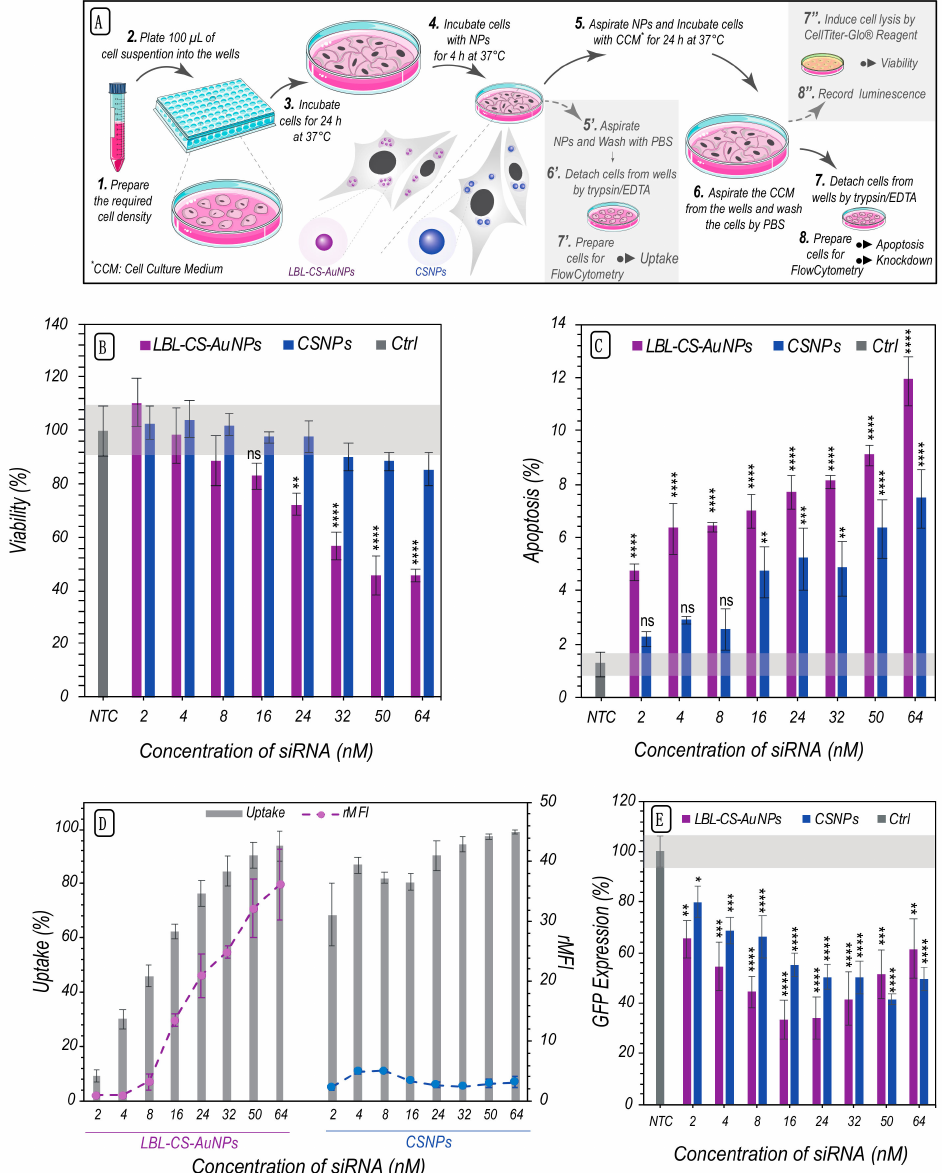
Figure 5. [-15]Comparison of siRNA Delivery, gene silencing efficiency and cytotoxicity between LBL-CS-AuNPs and CSNPs. ( A ) Schematic representation of the protocol used to evaluation of NPs as siRNA-delivery-carrier. ( B ) Cell viability for different effective concentrations of siRNA was measured by CellTiter-Glo ® assay after 4 h incubation with LBL-CS- AuNPs (siRNA:Au 1:10) and CSNPs. ( C ) Apoptosis for different concentrations was assessed based on mitochondrial integrity using DiIC 1 (5) and PI staining. ( D ) Uptake percentage (= % positive cells) and relative mean fluorescence intensities of AF647 siRNA labeled LBL-CS-AuNPs on H1299-eGFP cells were determined by flow cytometry. ( E ) The percent of GFP expression on H1299-eGFP cells was measure based on the mean GFP fluorescence intensity (MFI) of the cell by flow cytometry at different concentrations of LBL-CS-AuNPs loaded with GFP-siRNA. Data are represented as mean ± the standard error of the mean for a minimum of three independent experiments. Statistical significance, with respect to the not treated control (NTC), is indicated when appropriate (ns = not significant p > 0.05, * p ≤ 0.05, ** p ≤ 0.01, *** p ≤ 0.001, **** p ≤